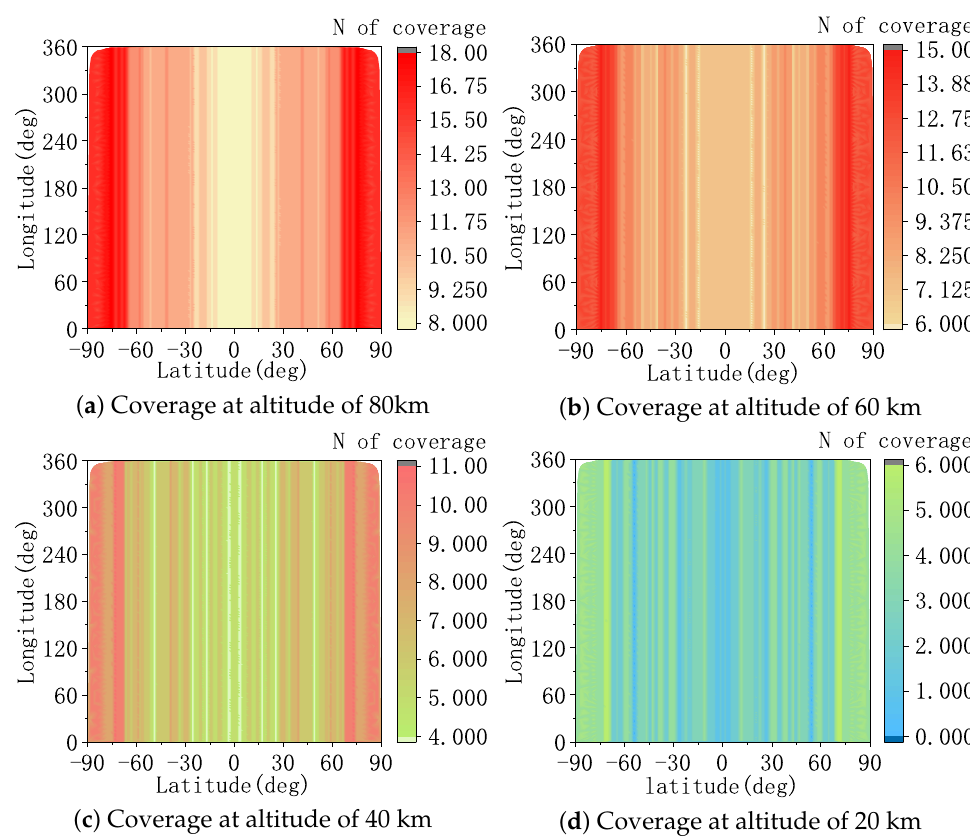
Figure 8. The coverage of near space by the